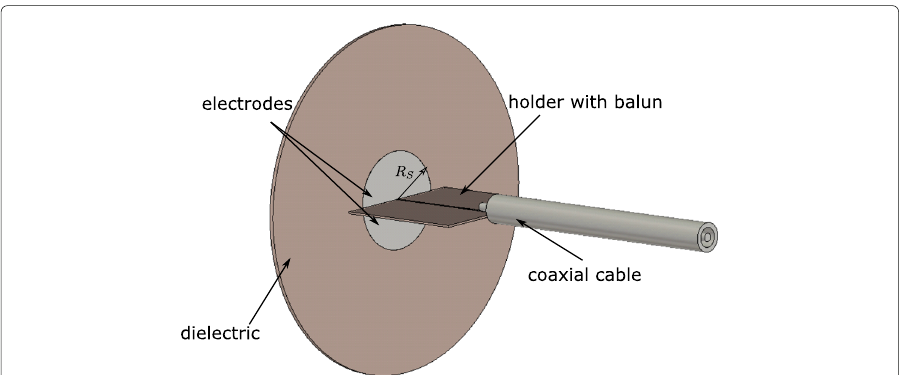
Fig. 2 Schematic of the pMRP (courtesy of D. Pohle, C. Schulz, and I. Rolfes), which consists of two half-disc electrodes with radius